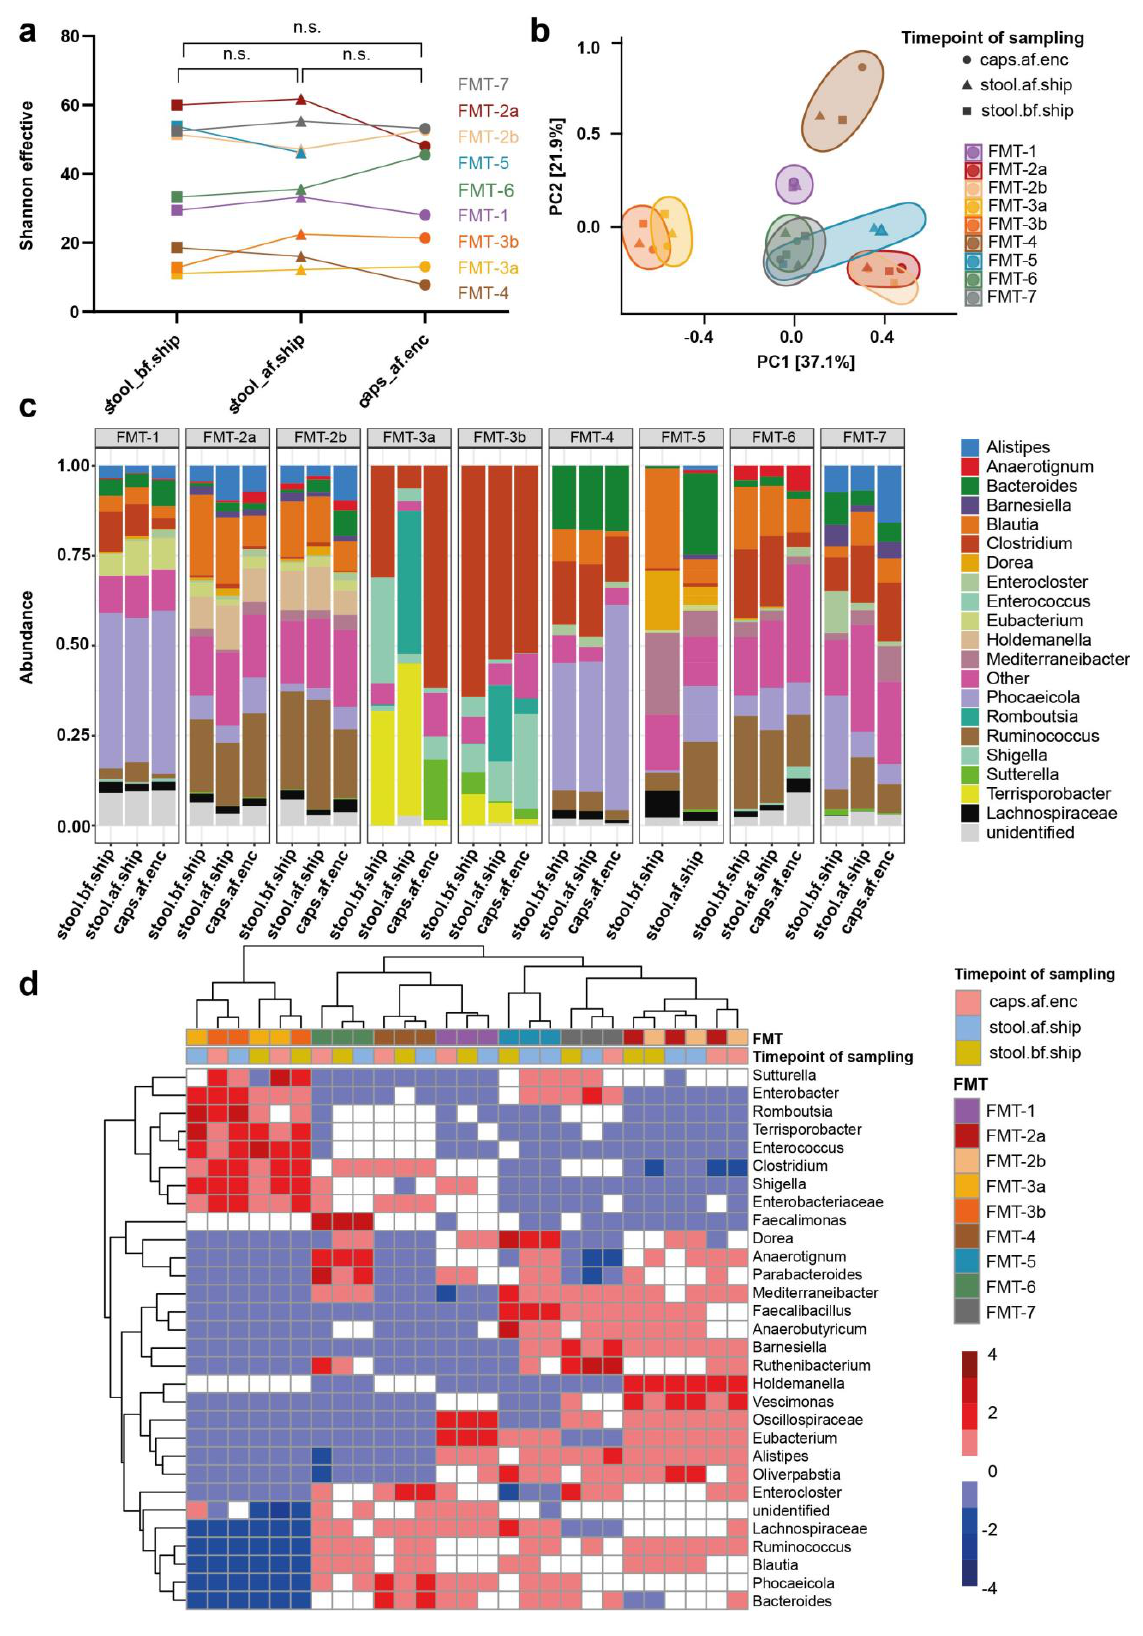
Figure 2. Microbial composition analysis of fecal samples pre- and post-shipment and after encapsu- lation as determined by 16S rRNA sequencing. ( a ) Shannon’s effective number of species plotted